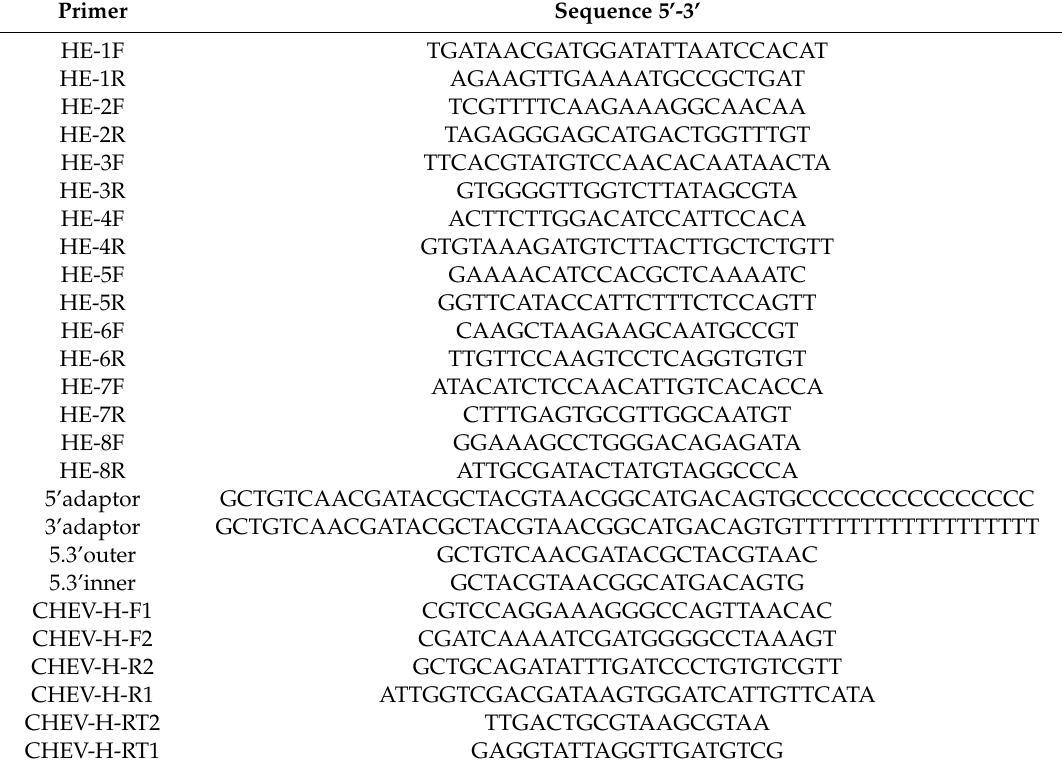
Table 1. Primers used for amplification and sequencing of the Crustacea hepe-like virus 1